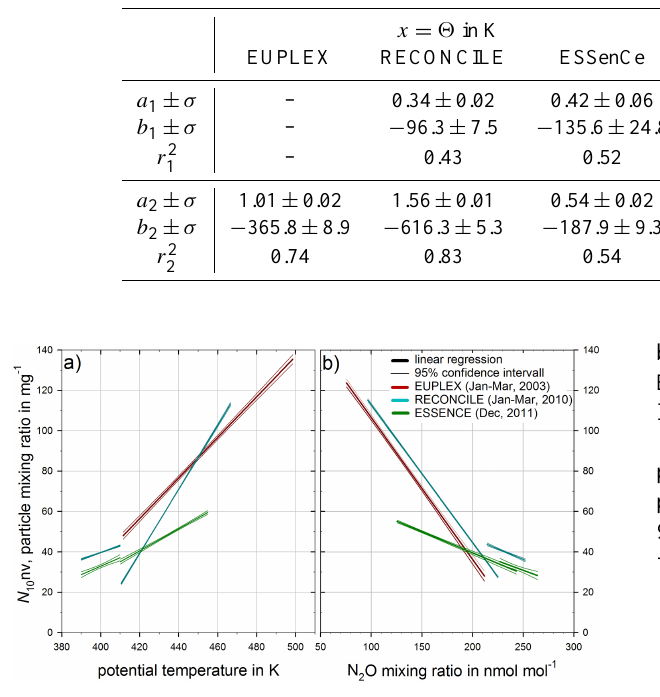
Figure 8. Linear regressions with 95% confidence interval for the mixing ratio of non-volatile particles N 10 nv as function of potential temperature (cid:50) (a) and N 2 O mixing ratio (b) . Results from mea- surements within the vortex ( (cid:49) N 2 O vortex index ξ vi > 0.75) are shown for the three Arctic missions: EUPLEX (2003), RECON- CILE (2010) and ESSenCe